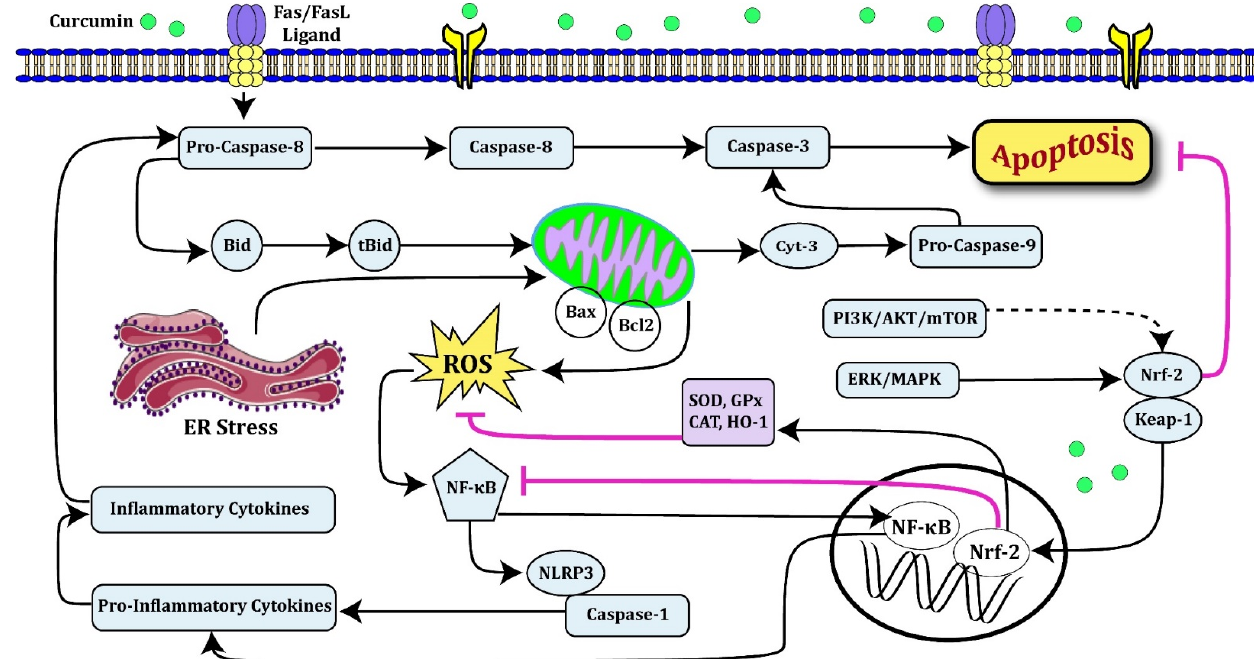
Figure 2. Oxidative stress formed by a number of disorders or external factors such as chemical drugs, heat stress, and so on could induce both extrinsic and intrinsic apoptotic pathways [75]. However, during abnormal conditions, endoplasmic reticulum (ER) stress could also activate the intrinsic apoptotic pathway [76], leading to cell death. On the other hand, disruption of Bax/Bcl-2 balance by mitochondrial dysfunction leads to ROS elevation [75]. Afterward, ROS activate the NF- κ B signaling pathway, subsequently increasing the release of inflammatory cytokines. Interestingly, antioxidant sources-such as curcumin-could decrease ROS production and cell death rate, finally. In this regard, curcumin via activating the Nrf2 pathway could increase the levels of cellular antioxidants [43,48], such as SOD, GPx, and CAT, and by activating the expression of HO-1 (Heme Oxygenase-1), as an Nrf2-regulated gene which is involved in the prevention of vascular inflammation, could directly or indirectly decrease the generation of ROS as well as inflammation [28,54]. On the one hand, it has been reported that curcumin via activating the ERK and MAPK could ease the oxidative damage